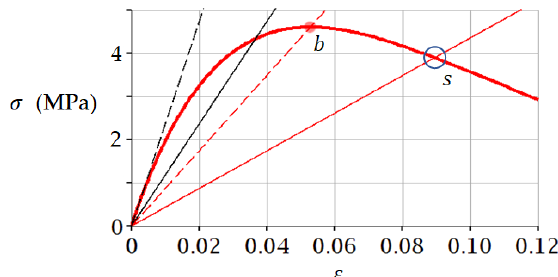
Figure 7. Stress–strain curve (5) for frozen sand under uniaxial compression. A secant (red dotted line) passes through point b , the slope angle of which determines the secant modulus of elasticity. At point s , failure is predicted by criterion (14), at this point the line σ = 0.5 ε E secant intersects the curve (5). The red curve simulates the experimental curve from [56].